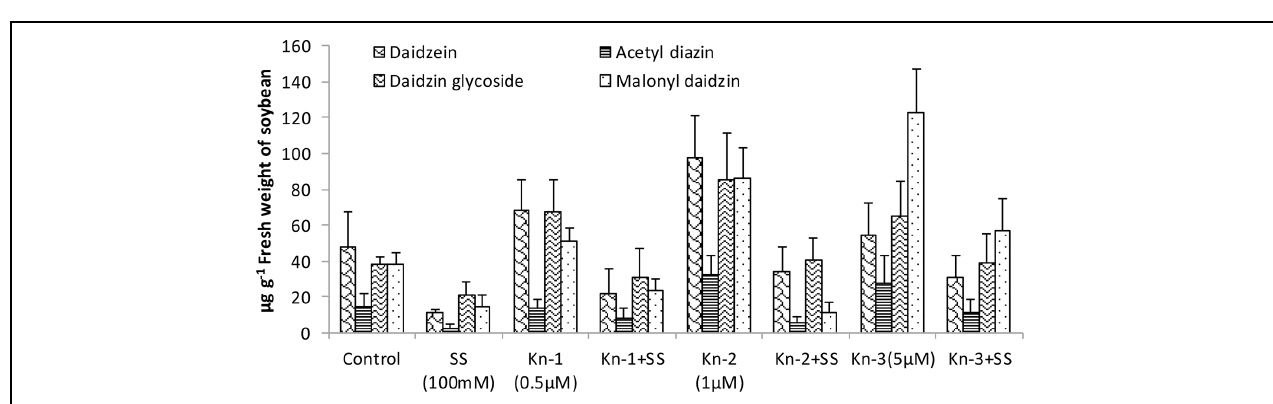
FIGURE 3 | Effect of Kn and salt stress on the concentrations of aglycones, acetyl glycosides, glycosides and malonyl glycosides of daizein in soybean cv. Daewonkong. Bars in the graph represent means of three replicated with ± SEM.